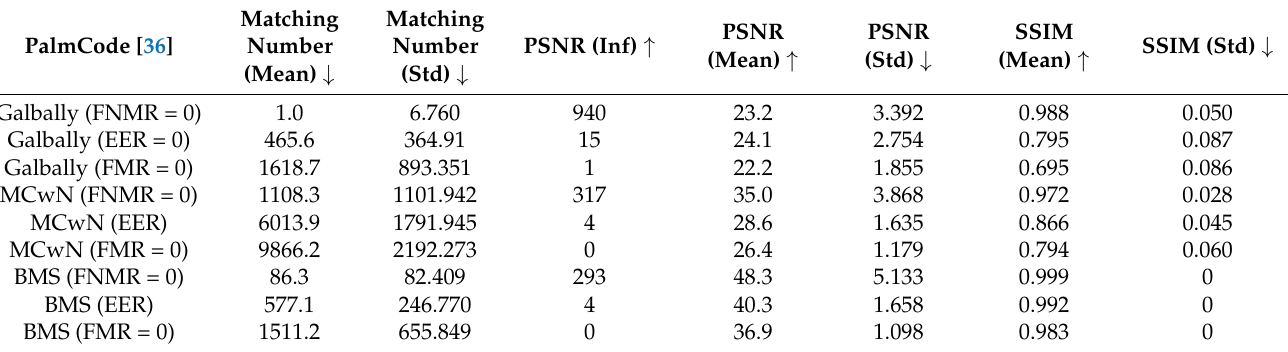
Table 3. Attack performance of PalmCode [36].